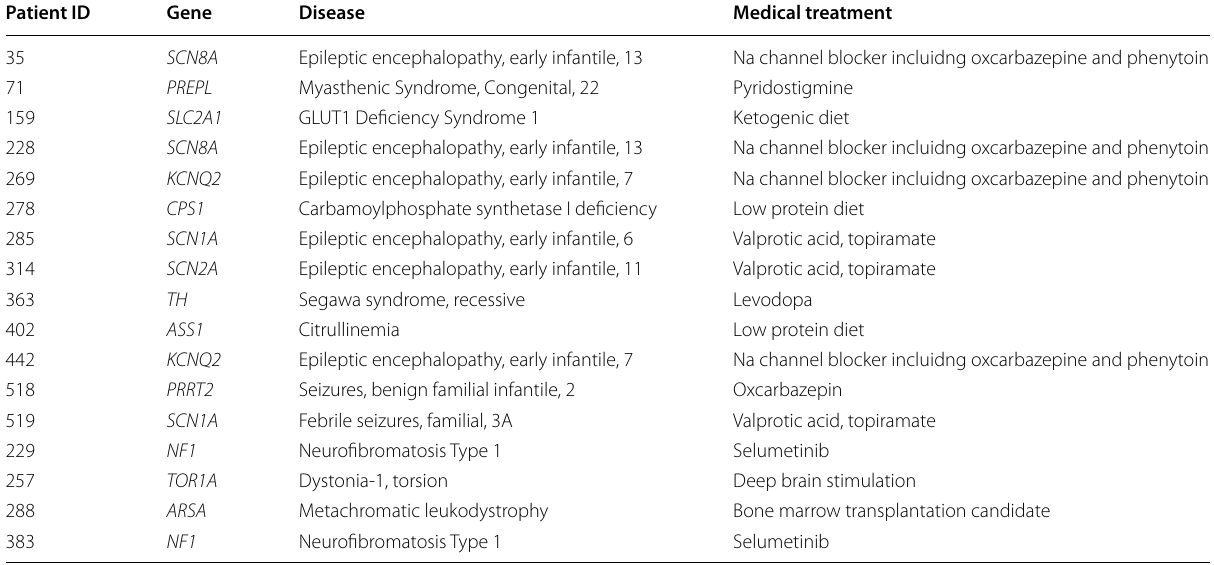
Table 3 The 16 patients in whom clinical management was changed after the genetic diagnosis Patient